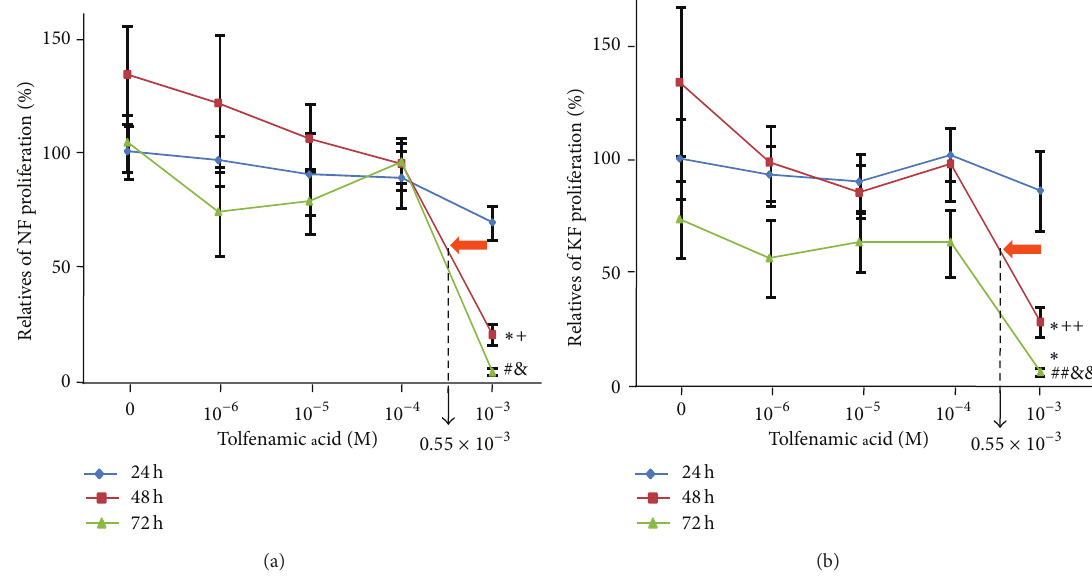
Figure 2: The dose- and time-responses of TA on cell proliferation in NFs and KFs. In 48 h exposure time group and 72 h exposure time group, 10 −3 M TA significantly decreased cell proliferation in NFs. 0, 10 −6 , 10 −5 , 10 −4 , 10 −3 , 0.55 × 10 −3 : M TA was dissolved in 1% DMSO. ∗ 𝑃 < 0.01 , 10 −3 M versus 0 M; + 𝑃 < 0.01 , 48 h versus 24 h; # 𝑃 < 0.01 , 10 −3 M versus 0 M or 10 −4 M; & 𝑃 < 0.01 , 72 h versus 24 h or 48 h; ∗∗ 𝑃 < 0.01 , 10 −3 M versus 0M; ++ 𝑃 < 0.05 , 48 h versus 24 h; ## 𝑃 < 0.05 , 10 −3 M versus 0M; && 𝑃 < 0.01 , 72 h versus 24 h or 48 h; 𝑛 = 6